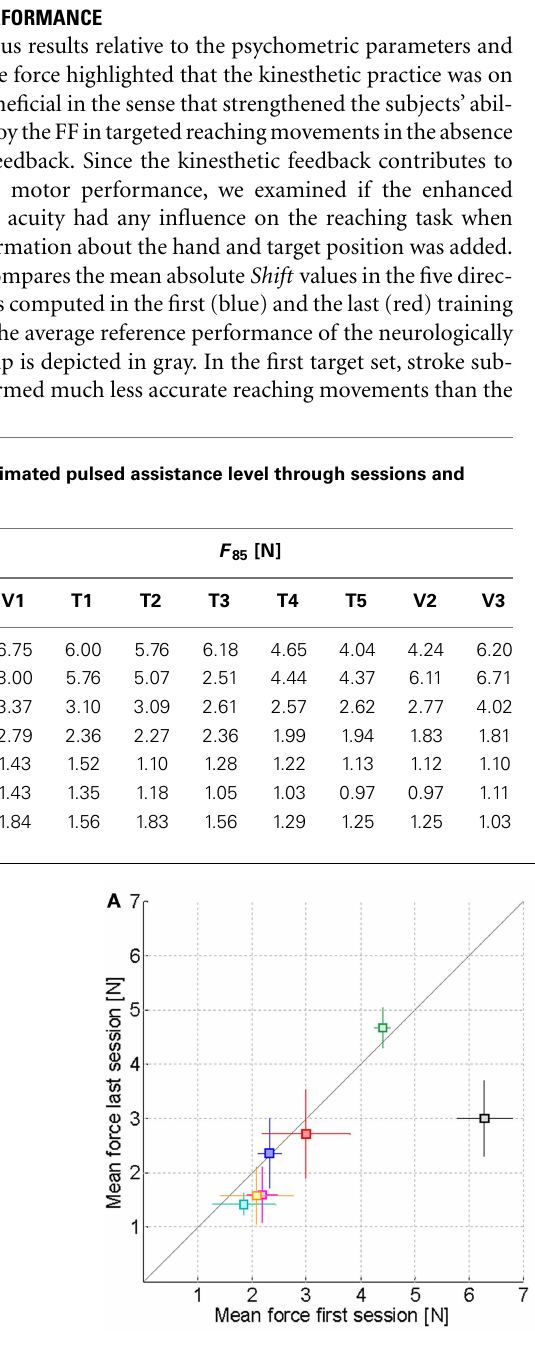
haptic guidance. (B) Mean AC index variation with respect to the desired level of kinesthetic performance AC d = 0.85 in the first training session (T1) and in the last one (T5).The gray area includes all the AC values within the tolerance margin of 5% allowed below the desired AC percentage.Values have been corrected for the difference between the actual AC d of each subject along a specific direction and the ideal value of